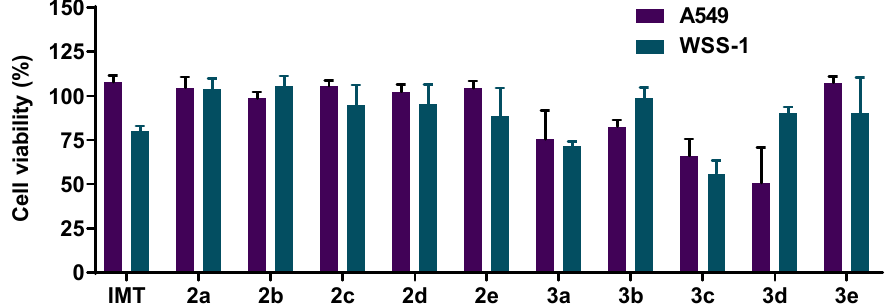
Figure 3. Screening of imatinib and its derivatives 2a-e and 3a-e at a concentration of 10 µM against human cell lines A549 (purple) and WSS-1 (green). Bars represent the mean ± standard deviation. Table 2 shows the IC 50 and SI values of imatinib and its most cytotoxic analogs ( 3a , 3c and 3d ) in A549 cells. Table 2. Cytotoxic activity and selectivity index of imatinib and derivatives 3a , 3c and 3d in the A549 and WSS-1 cells.